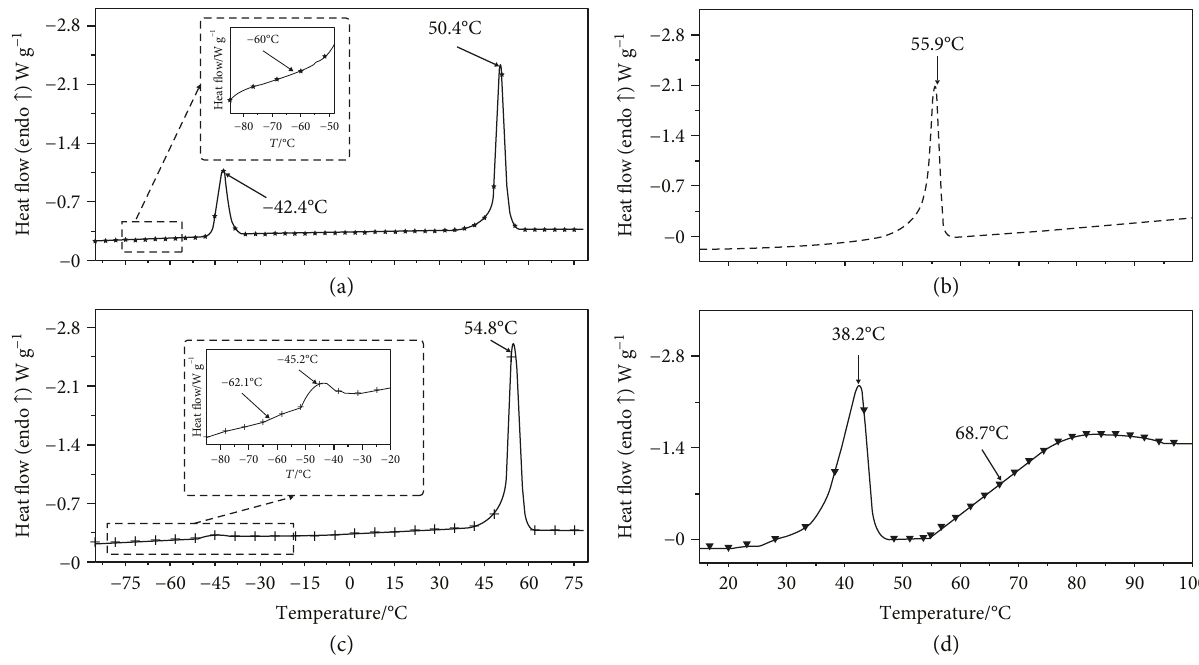
Figure 5: DSC curves of (a) P (DMS- b - ε -CL) SCL1, (b) P (DMS- b - ε -CL) SCL4, (c) linear PCL homopolymer, and (d) P (HEMA- co -(HEMA- g - ε -CL)- b - ε -CL) HEMACL3 copolymers.